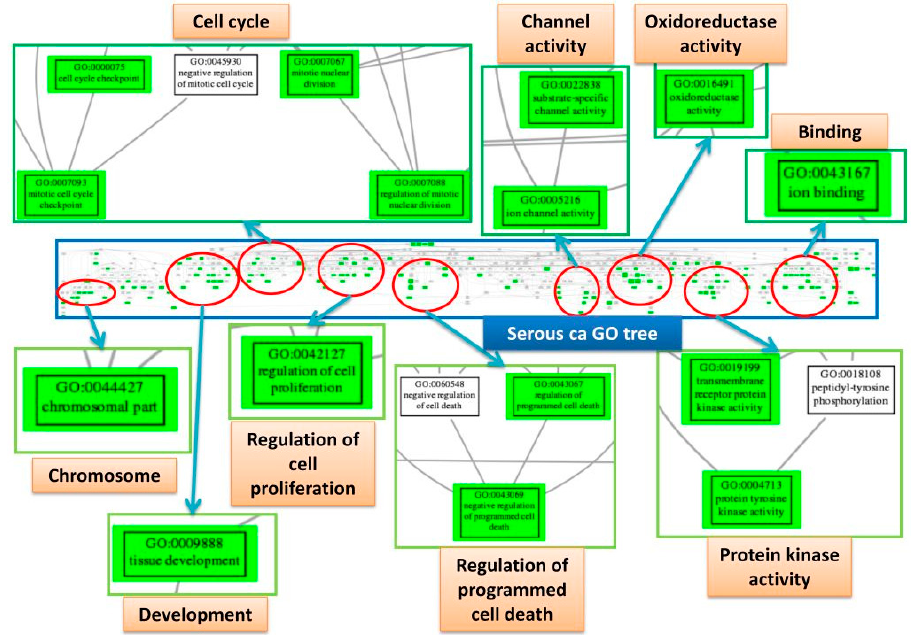
Figure 6. GO tree of SC. This figure displayed the screenshot of the full GO tree for SC (middle). After mapping to the GO tree, the similar GO terms clustered together. Each cluster was circled (red) and some of the important deregulated GO terms (green boxes) in the cluster were magnified to view the details. Each cluster was labeled by the common parental GO term (orange rectangle).